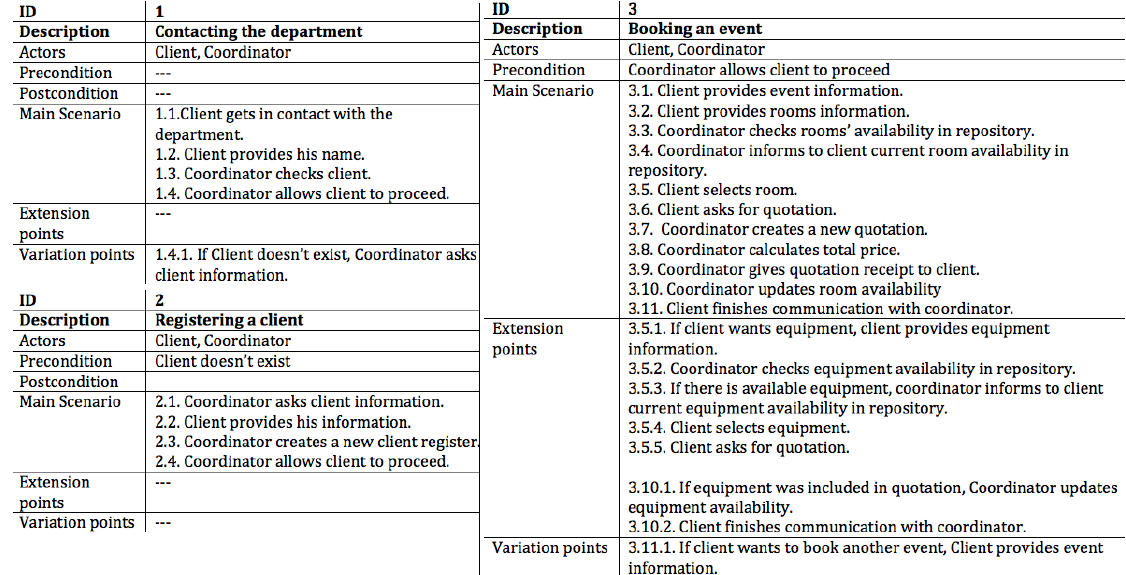
Fig. 1. Specification of business use cases for room renting system for